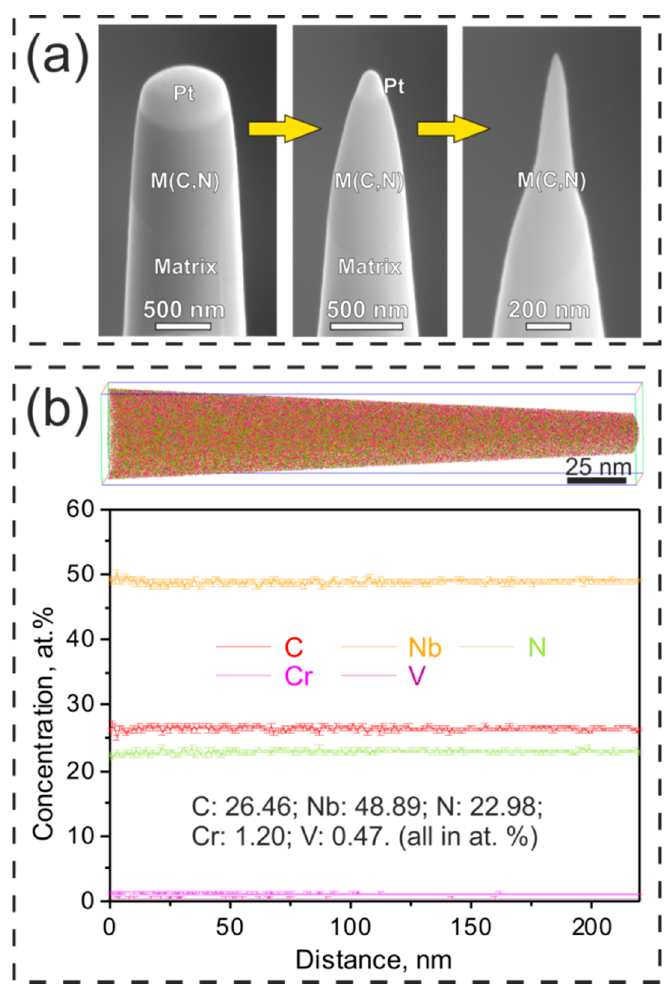
Figure 4. ( a ) Secondary electron (SE) images showing the preparation process of the atom probe tomography (APT) tips of carbonitrides by focus-ion beam (FIB) technique. The Pt layer was employed to mark and protect the target carbonitride during lift-out process. ( b ) Three-dimensional reconstruction and one-dimensional compositional profiles of all elements in a representative APT tip taken from a carbonitride in the solution-treated Super304H steel.